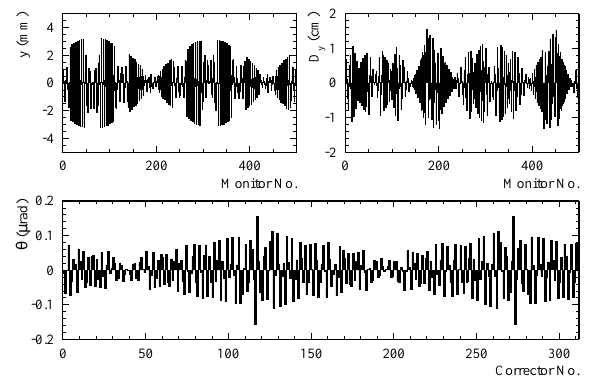
FIG. 4. Normalized orbit ( w 1 (cid:2) y (cid:1) 9 (cid:2) (cid:4) w 9 ) and kick ( vector for eigenvalue number 9 (see also Fig. 3). The orbit (top left) and dispersion (top right) components of (cid:2) y (cid:1) 9 (cid:2) are shown to- gether with the corrector setting corresponding to